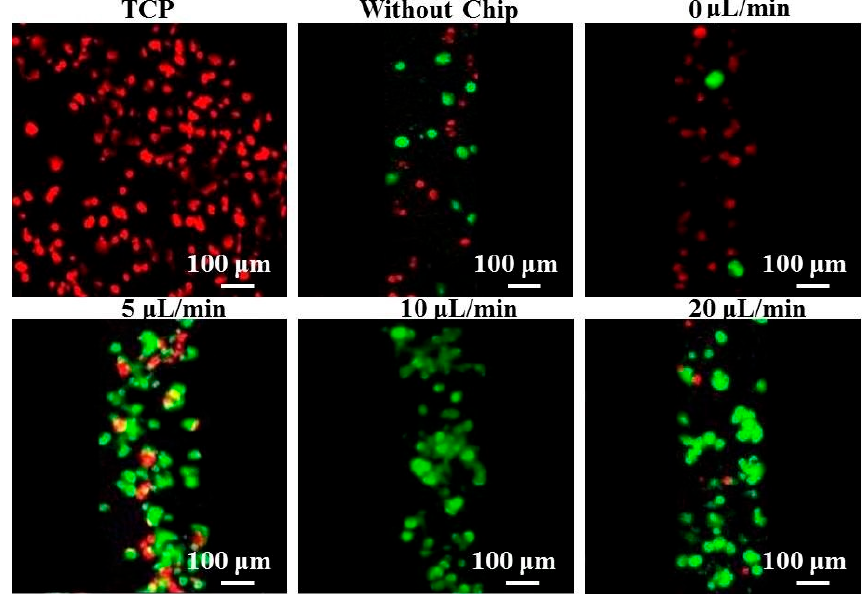
Figure 3. Confocal laser scanning microscope (CLSM) images of calcein-AM ( green ) and propidium iodide ( red and yellow ) stained hepatocytes after 3 days of culture on different substrates.